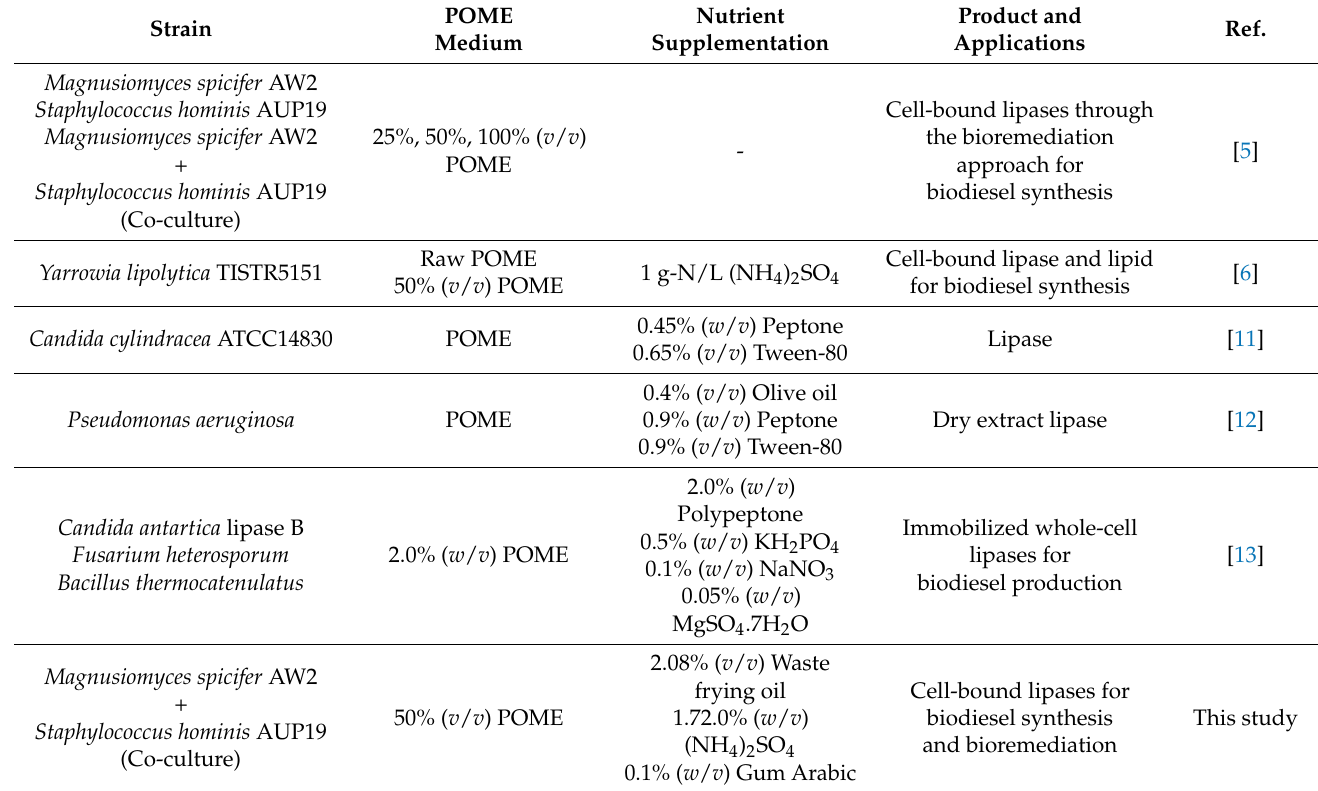
Table 1. Palm oil mill effluent (POME) as a growth medium for lipase